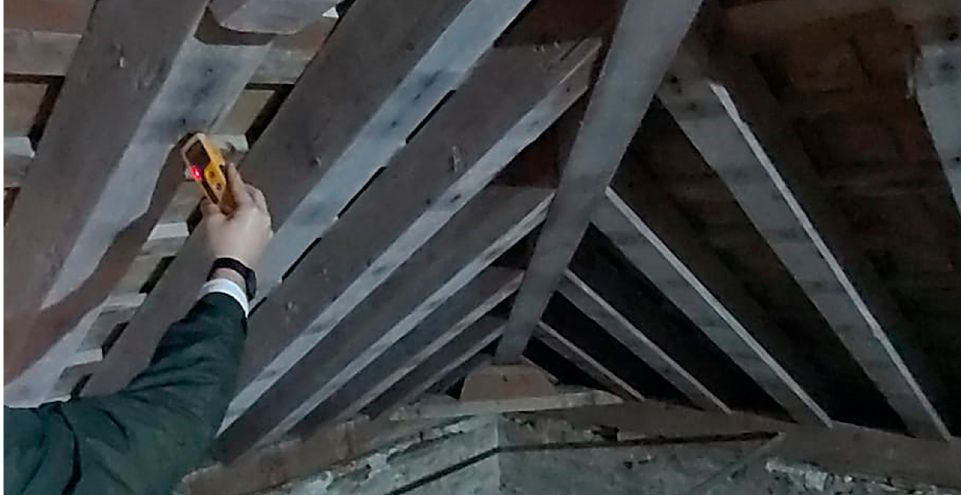
Figure 11. Protimeter Survemaster SM measuring the wood moisture content.